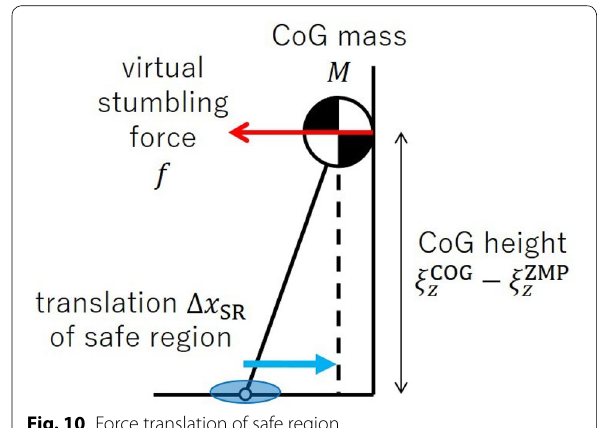
Fig. 10 Force translation of safe region